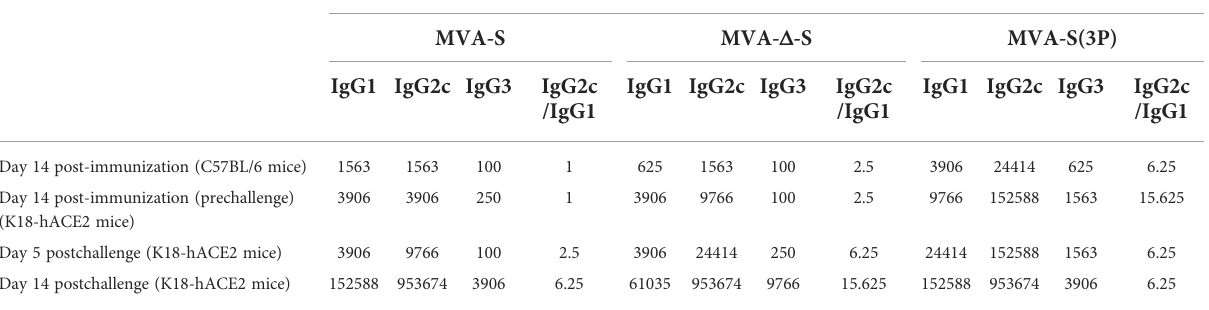
TABLE 1 Isotype analysis of anti-S IgG antibodies in immunized C57BL/6 and transgenic K18-hACE2 mice. Time points